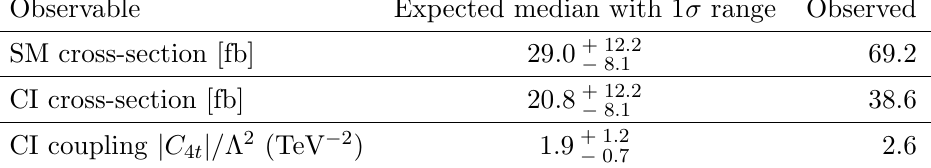
Table 14 . Expected and observed 95% CL upper limits on the four-top-quark production cross- section in various